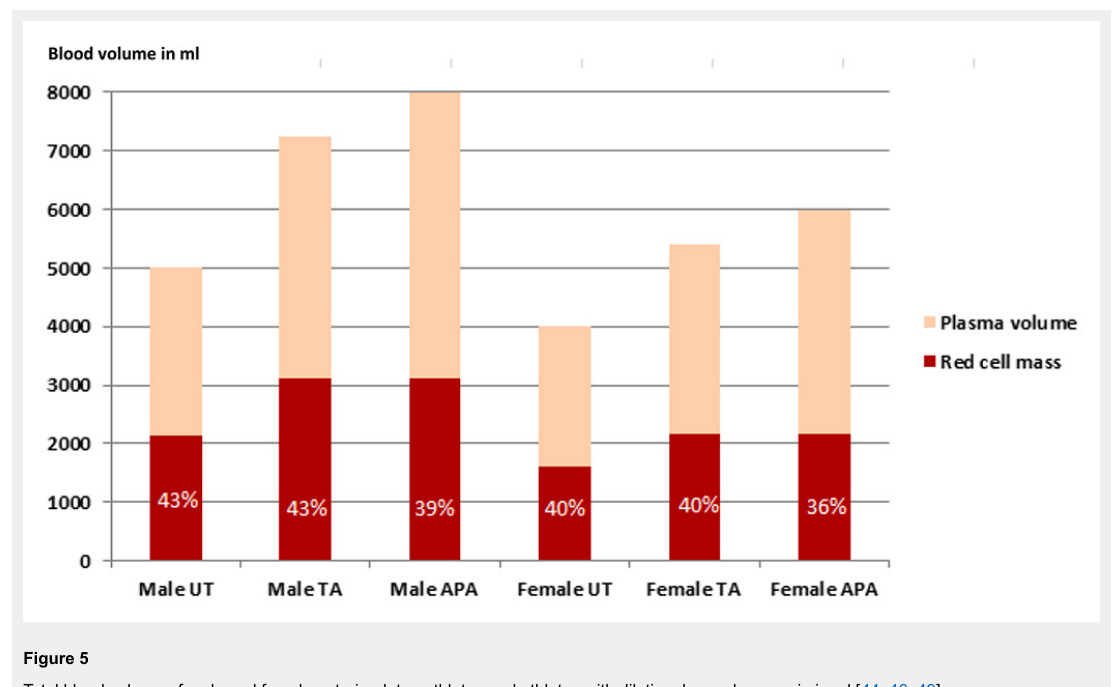
Figure 5 Total blood volume of male and female untrained, top athletes and athletes with dilutional pseudoanaemia in ml [44, 46, 49]. APA = athlete with dilutional pseudoanaemia; TA = top athlete; UT = untrained In the column of the red cell mass the haematocrit in percentage is shown in white